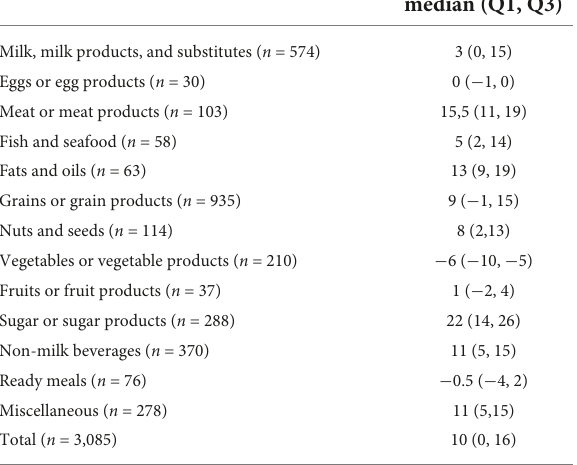
branded food composition databases (BFCD)